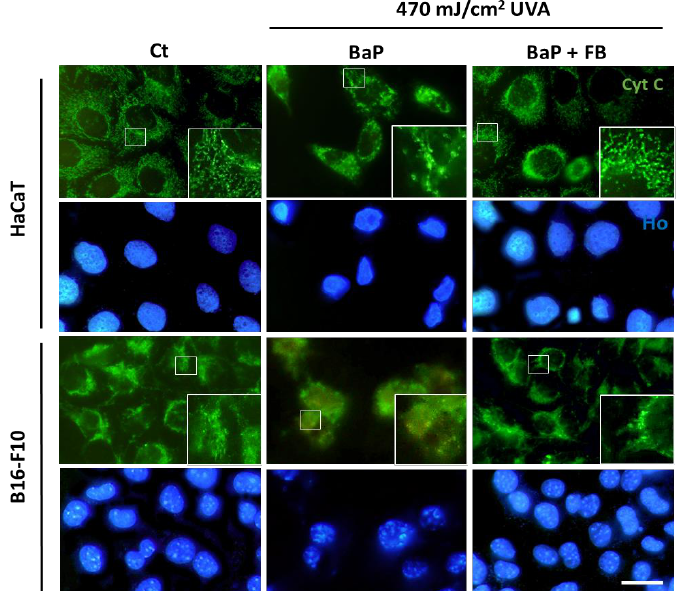
Figure 5. Effect of BaP and FB exposed to UVA light on the dynamics of cytochrome C in HaCaT and B16-F10 cells. Cells were incubated with BaP and BaP + FB and immediately after exposed to 470 mJ/cm 2 of UVA light. 24 h after irradiation, cytochrome C localization was evaluated. The results showed altered mitochondrial morphology and cytochrome C release in cells treated with a combination of BaP and UVA light. In both cell lines, cells treated with BaP + FB followed by UVA light irradiation showed heterogeneity in cytochrome C localization. Some cells retained a normal mitochondrial morphology, while others released the molecule to the cytoplasm. This suggests a partial protective effect of FB. Scale bar: 20 µ m.